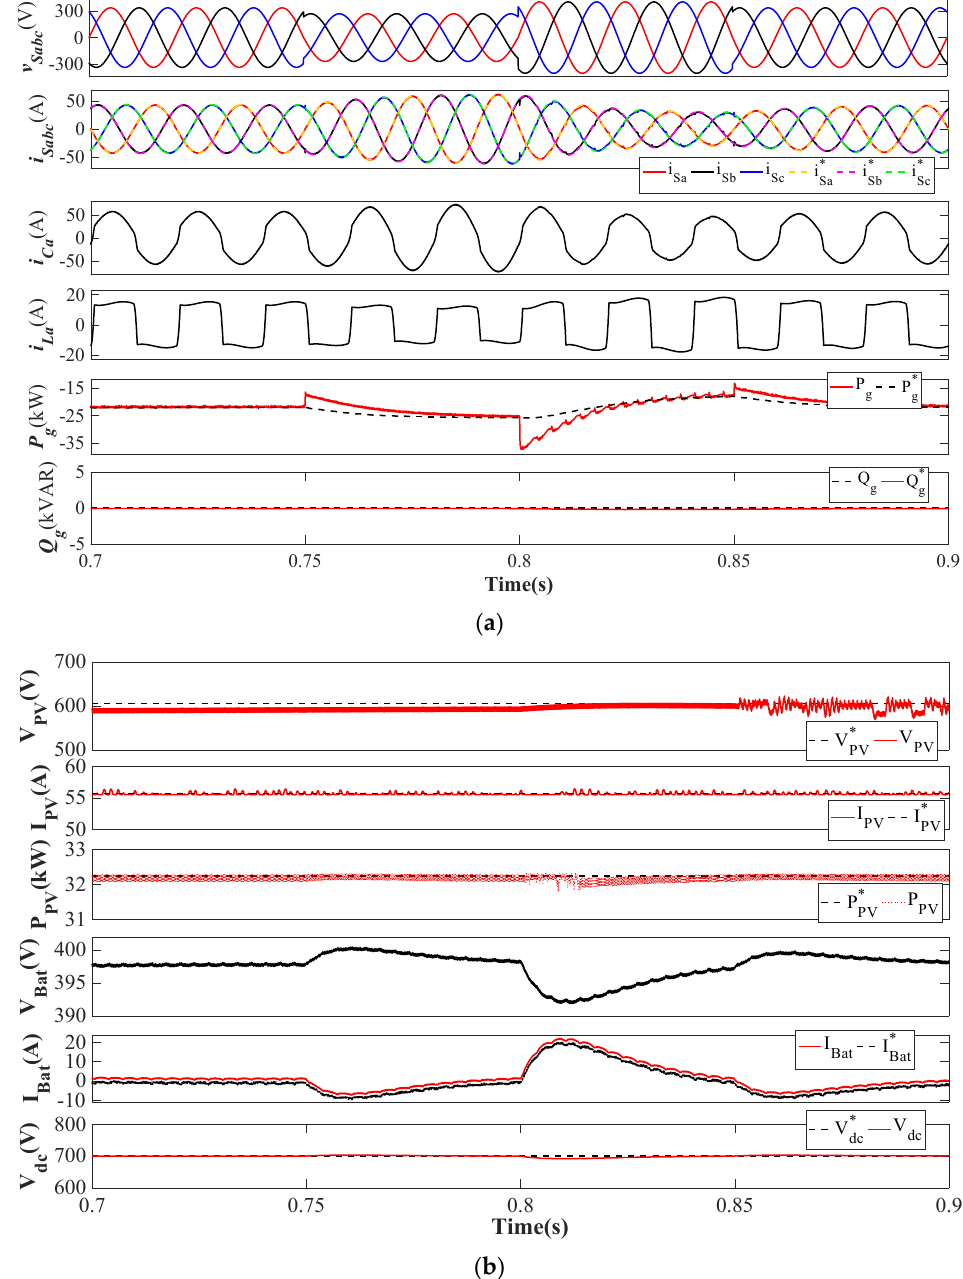
Figure 14. Abnormal grid voltage variation analysis of ( a ) v sabc , i sabc , i Ca , i La , P g & Q g ( b ) V PV , I PV ,P PV ,V Bat , I Bat , & V dc The internal control signals involving 𝜇 (cid:3043)(cid:3028) , 𝑖 (cid:3020)(cid:3028)∗ , W (cid:2911)(cid:2932)(cid:2917) , W (cid:2900)(cid:2906) , and W (cid:2929)(cid:2926) are presented in Figure 15. The 𝜇 (cid:3043)(cid:3028) remains sinusoidal with unity magnitude throughout the operation. The 𝑖 (cid:3020)(cid:3028)∗ magnitude changes under the induced diverse dynamic conditions. The W (cid:2911)(cid:2932)(cid:2917) re- duces during load unbalancing, as the weight signal of phase ‘a’ diminishes to zero. The W (cid:2911)(cid:2932)(cid:2917) also varies during abnormal grid voltage as weight signals of each phase changes as per voltage sag and swell. The W (cid:2900)(cid:2906) tries to balance the active power flow through the DC link. The W (cid:2929)(cid:2926) varies as a function of W (cid:2911)(cid:2932)(cid:2917) and W (cid:2900)(cid:2906) . Figure 16 shows the W (cid:2911)(cid:2932)(cid:2917) variations with proposed AKWSOMCC, MCC, LMF and LMS control during diverse dynamic con-